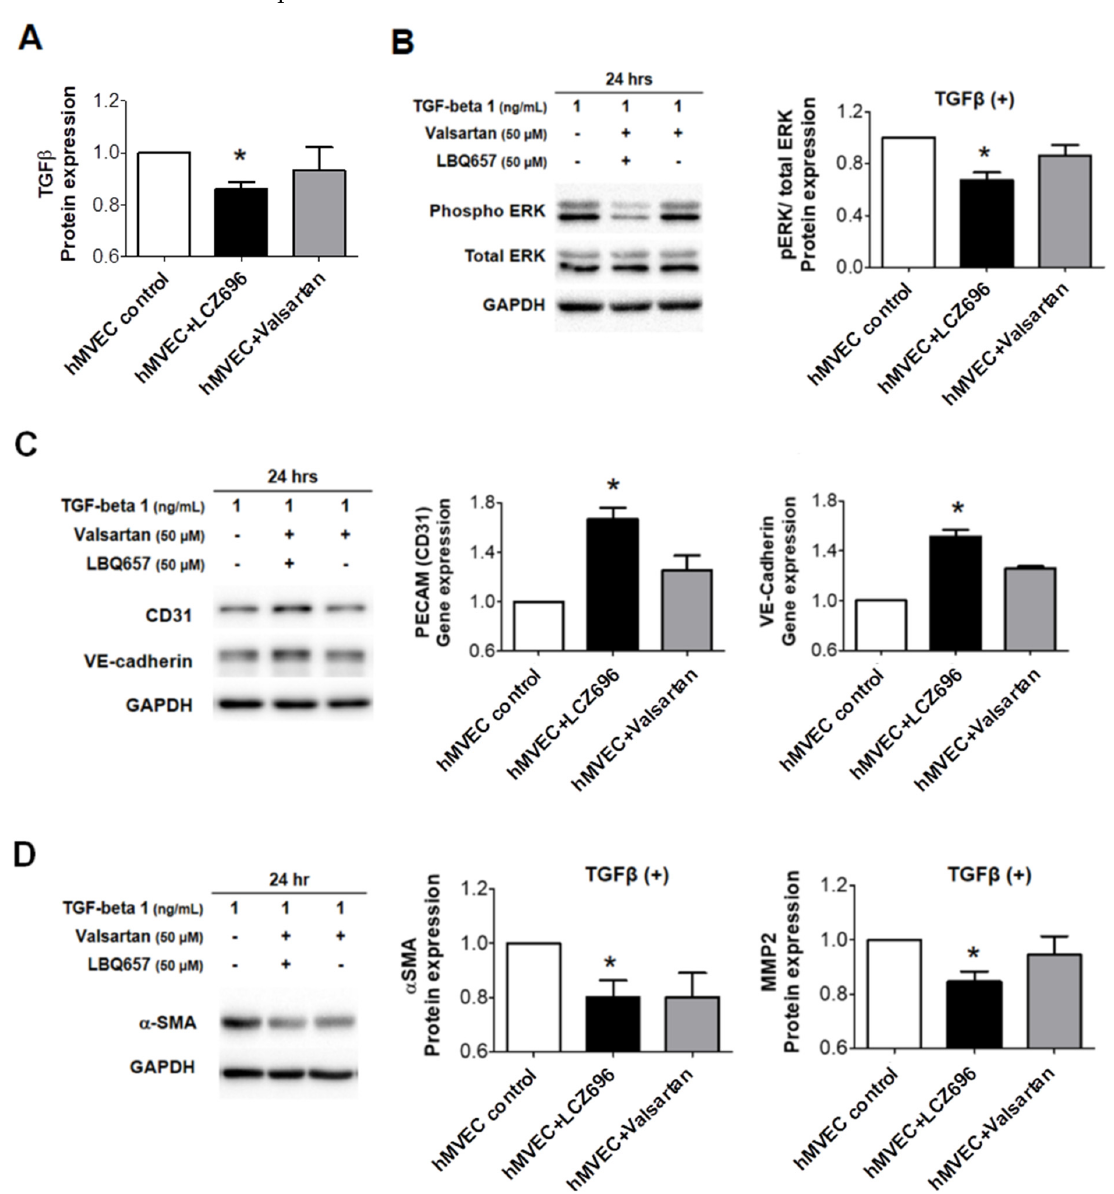
Figure 4. ( A ) TGF- β protein levels in human mitral valve endothelial cells (hMVECs) treated with LCZ696 or valsartan as determined by Western blots. Values represent the fold changes relative to the mean value measured in the control group. ( B ) Immunoblot analysis of total ERK, phosphorylated ERK, and GAPDH from hMVECs treated with LCZ696 or valsartan after TGF- β stimulation. Quantification of ERK density is relative to GAPDH. Values represent fold changes of the mean values relative to the control group. ( C ) Immunoblot analysis of CD31, PECAM, and GAPDH from hMVECs treated with LCZ696 or valsartan after TGF- β stimulation. Quantification of CD31 and PECAM density is relative to GAPDH. Values represent fold changes of the mean values relative to the control group. ( D ) Immunoblot analysis of α -SMA and GAPDH from hMVECs treated with LCZ696 or valsartan after TGF- β stimulation. Quantification of α -SMA density is relative to GAPDH. Values represent fold changes of the mean values relative to the control group. hMVECs indicates human mitral valve endothelial cells; TGF- β , transforming growth factor- β ; MV, mitral valve; hrs, hours; ERK, extracellular signal-regulated kinase; GAPDH, glyceraldehyde-3-phosphate dehydrogenase; PECAM, platelet endothelial cell adhesion molecule; CD31, cluster of differentiation 31; VE-cadherin, vascular endothelial cadherin; α -SMA, α -smooth muscle actin; MMP, matrix metallopeptidase. * p < 0.05 for differences from the control group.